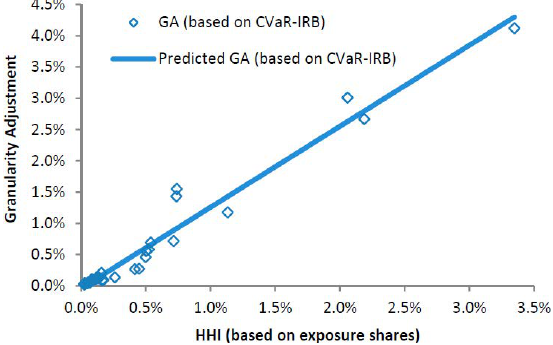
Fig. 3 Loss distribution of Sichuan KK Rural Commercial Bank’s agricultural loan